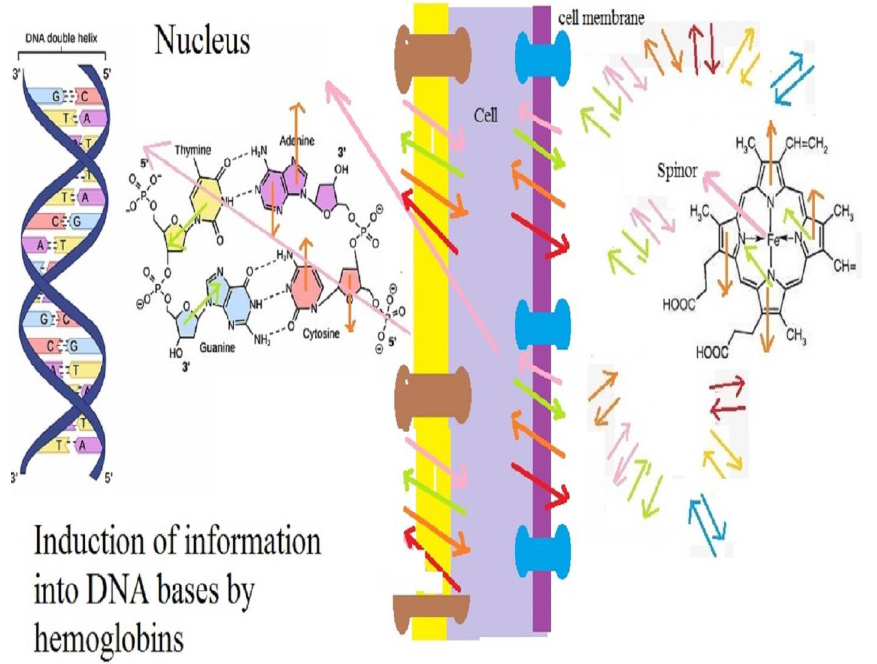
Figure 4. Induction of information (spinor waves) into multi-gonal molecules of hemoglobin by the heart—a hypothesis.